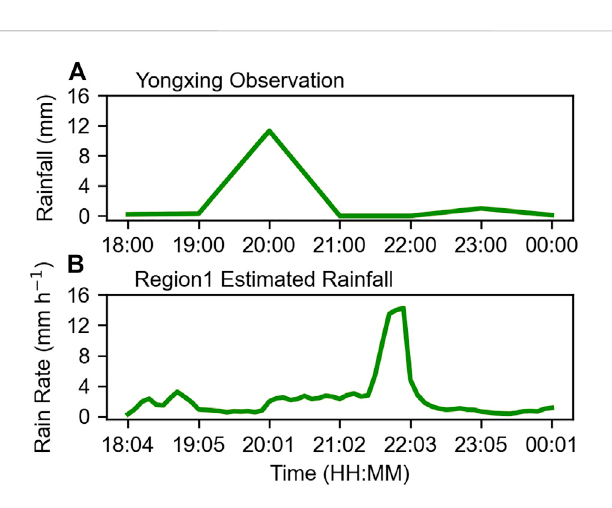
FIGURE 1 Time series of (A) hourly rainfall (units: mm) observed on Yongxing Island and (B) rain rate (units: mm h − 1 ) of Region 1 obtained by radar quantitative precipitation estimation on 16 October 2021 (UTC + 8, the same